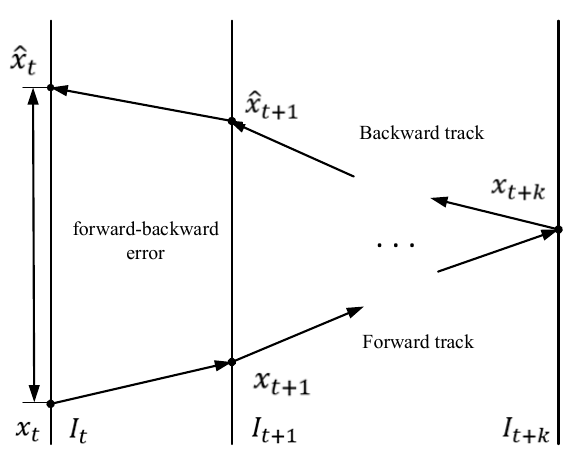
Figure 1. The calculation diagram of forward–backward (FB) error.